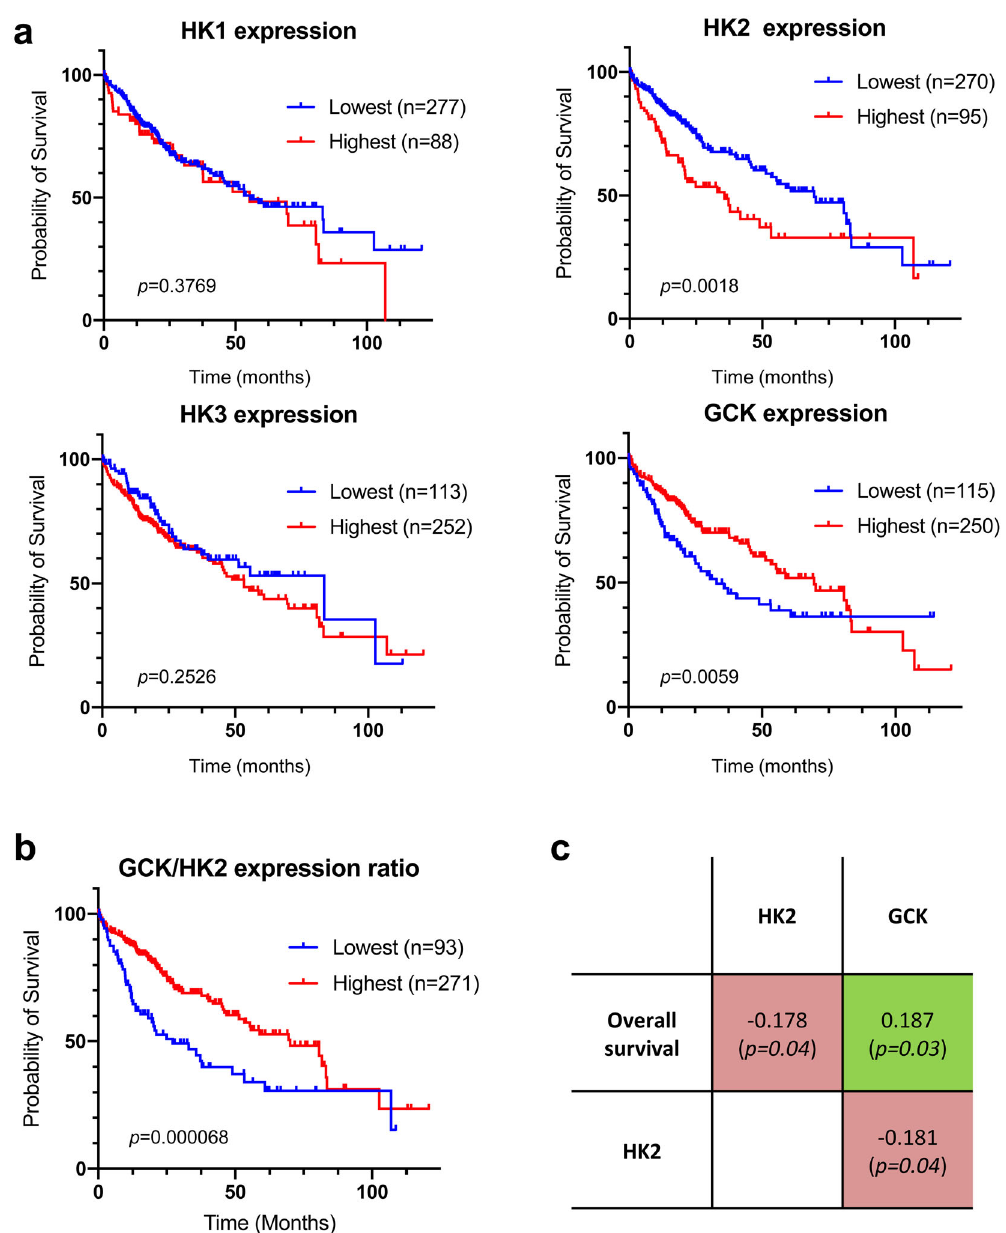
Fig. 1 Correlation between hexokinase expression levels in HCC tumors and patient survival. a Kaplan – Meier estimates of the survival of HCC patients depending on the expression of HK1 , HK2 , HK3 and GCK ( HK4 ) genes in tumor biopsies ( n = 365; diploid samples; TCGA expression data retrieved from cBioPortal; Firehose Legacy) 74,75 . Duplicate analyses from the same patient were removed as well as patients who died when biopsied (overall survival = 0 months or not speci fi ed). Optimal strati fi cation based on highest and lowest gene expression values was determined using Protein Atlas database 18 . b Same as above but patients were strati fi ed based on the GCK/HK2 gene expression ratio. The strati fi cation showing the lowest p value when comparing subgroups of patients with the highest to the lowest GCK/HK2 expression ratio is displayed. Patient TCGA-DD-AAE9 exhibiting undetectable levels of GCK and HK2 was removed from this analysis as the GCK/HK2 ratio could not be calculated. c Correlations between patient survival, GCK expression and HK2 expression. Spearman ’ s rank correlation test on the subset 130 patients for whom the period between diagnosis and death is precisely known (uncensored